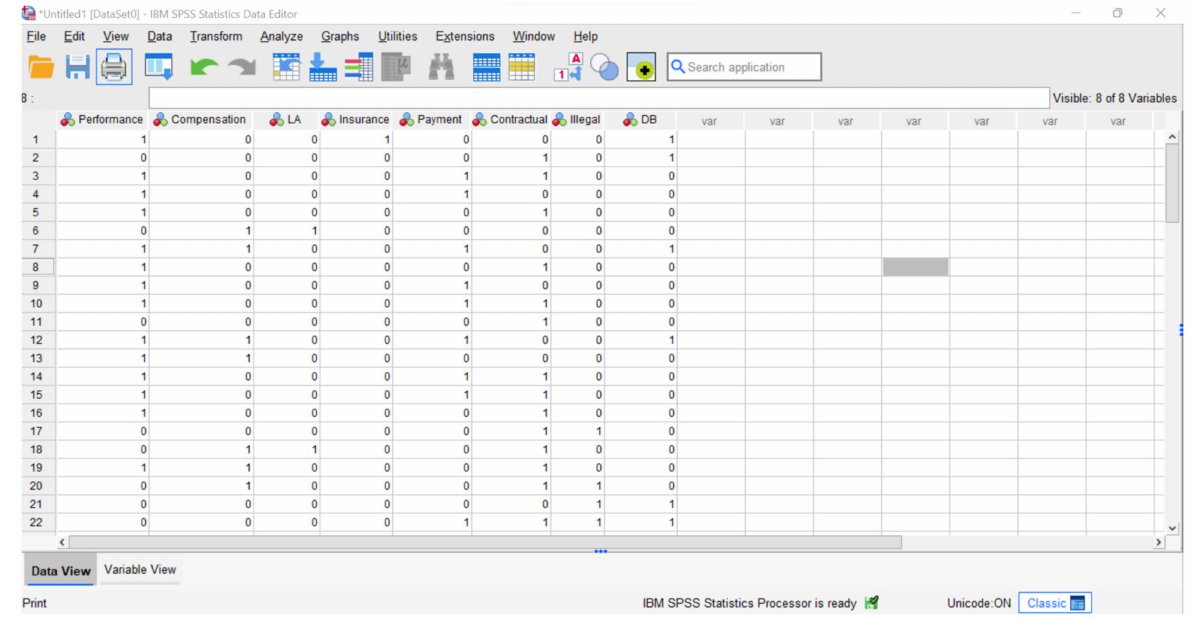
Figure 1. Data input into SPSS software.